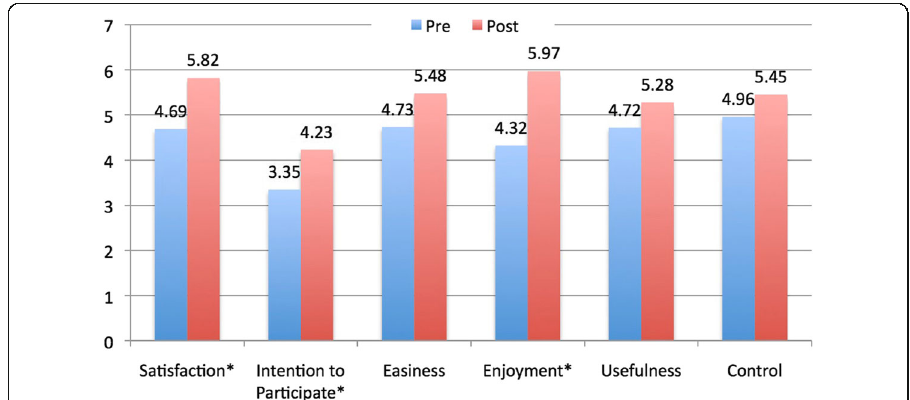
Fig. 6 The influence of the interactive display on students ’ engagement (* depicts significant